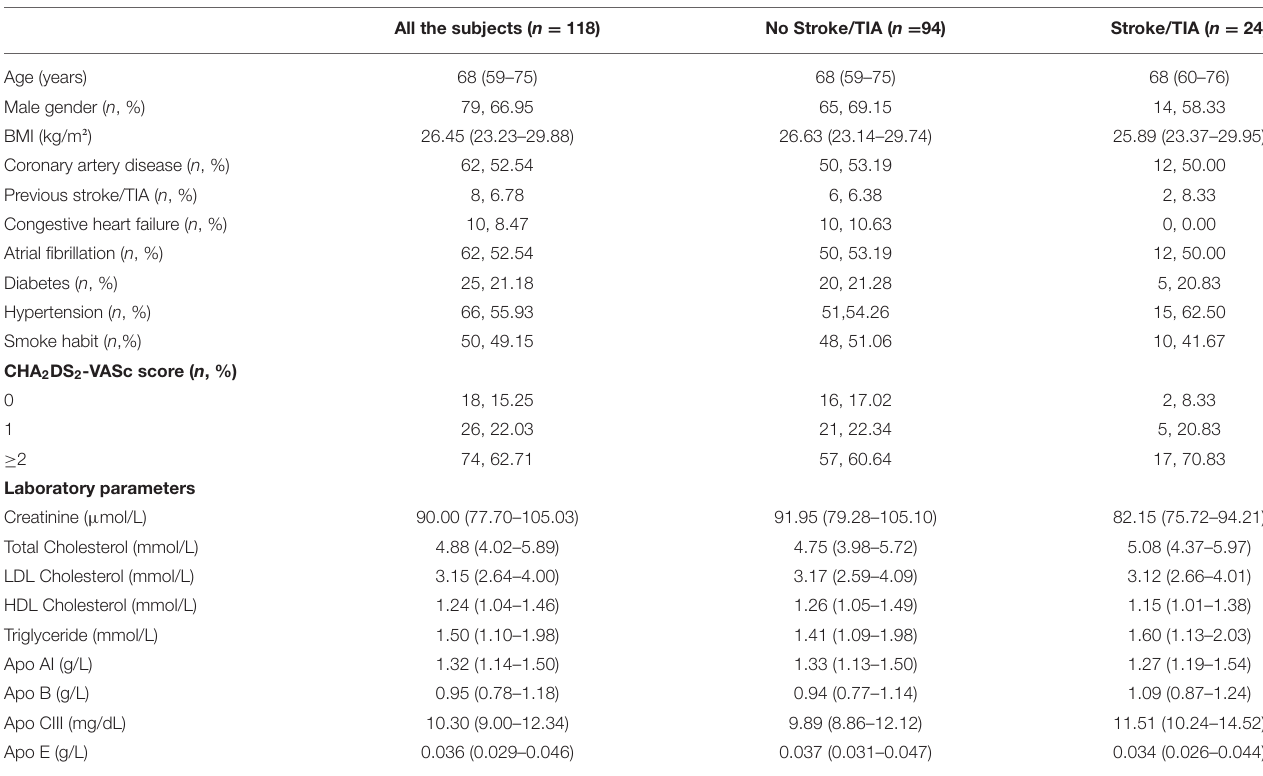
TABLE 1 | Clinical and laboratory characteristics of the study sample at time of enrollment considered as a whole and subdivided on the basis of the occurrence of non-fatal ischemic stroke or TIA events during the follow-up. All the subjects ( n =